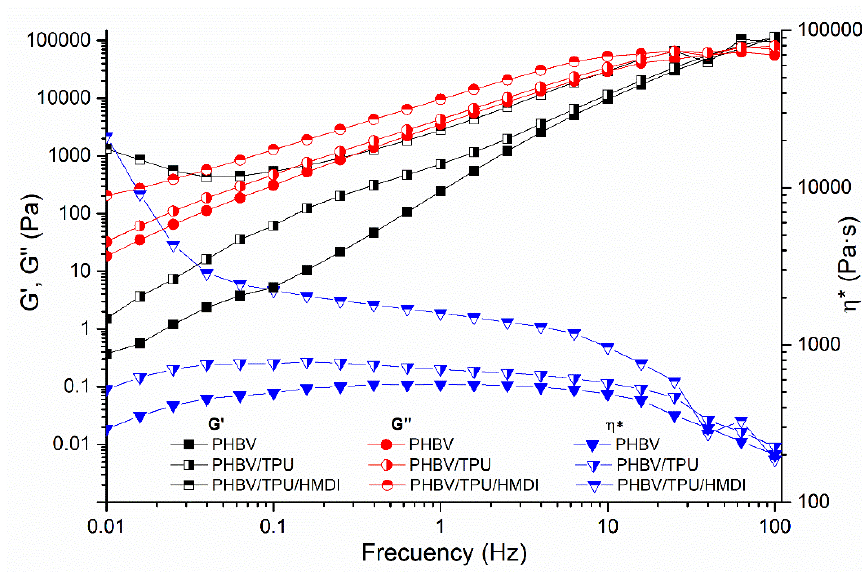
Figure 5. The storage modulus (G ′ ), loss modulus (G ″ ), and complex viscosity ( ƞ *) as a function of the frequency of neat PHBV and PHBV/TPU blends.